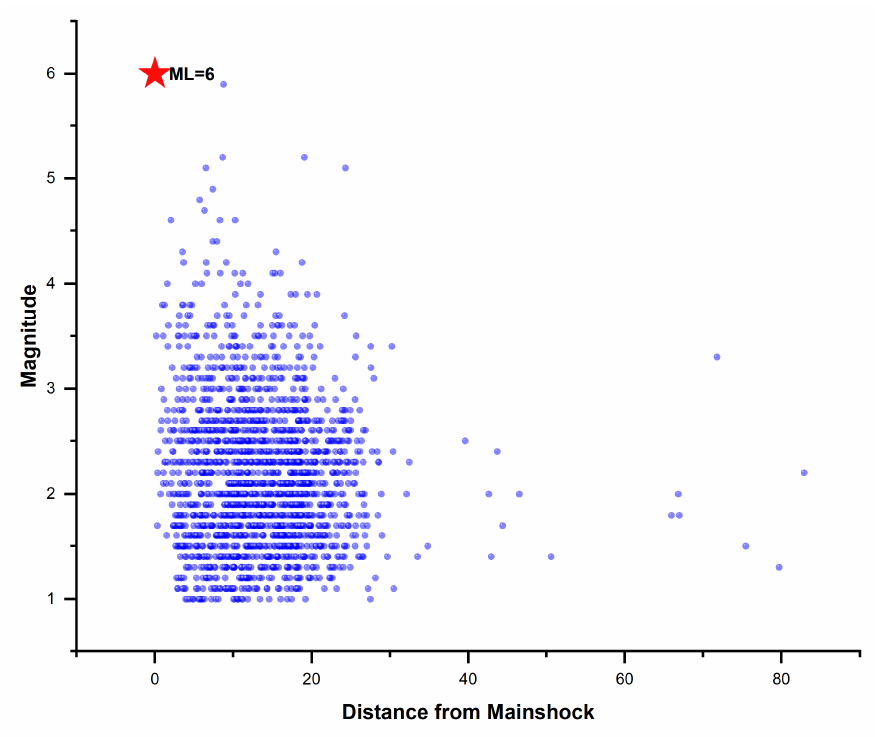
Figure 12. Location with distance (km) from mainshock as a magnitude (M L ) function for the 3.787 events recorded. On the x -axis is the distance from the mainshock, while on the y-axis is the magnitude of each aftershock.